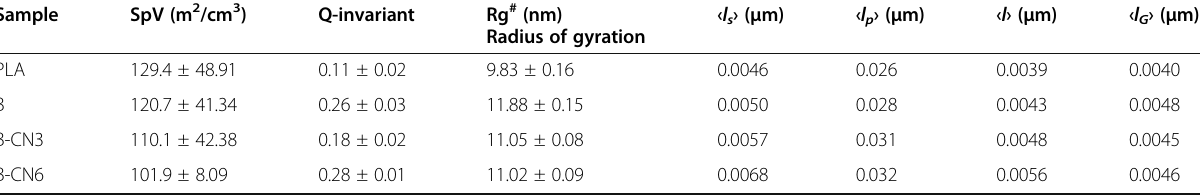
Table 3 Morphological properties based on surface area analysis from X-ray scattering Sample SpV (m 2 /cm 3 )